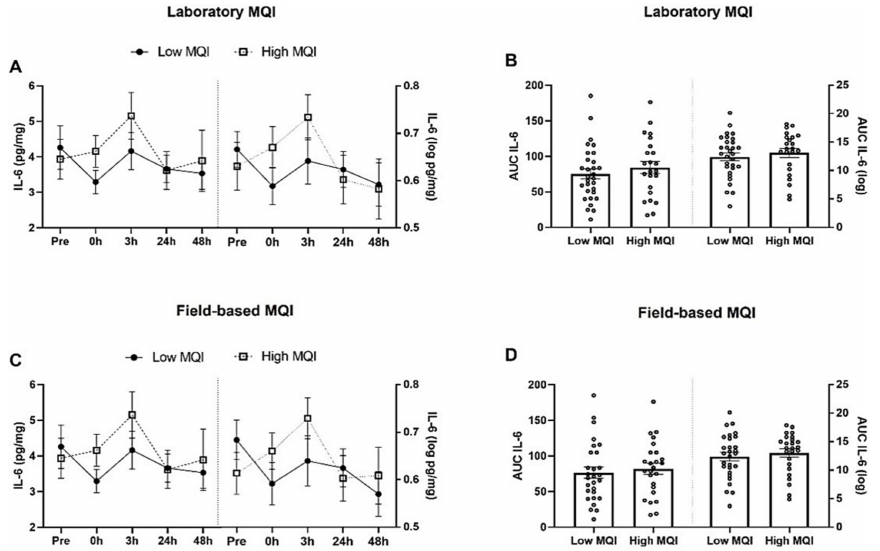
Figure 2. Interleukin 6 (IL-6) levels in blood circulation (mean ± SE) after an acute bout of eccentric exercise in older obese women with low and high muscle quality. ( A ) Laboratory IL-6 levels; ( B ) AUC laboratory IL-6 levels; ( C ) field-based IL-6 levels; ( D ) AUC field-based IL-6